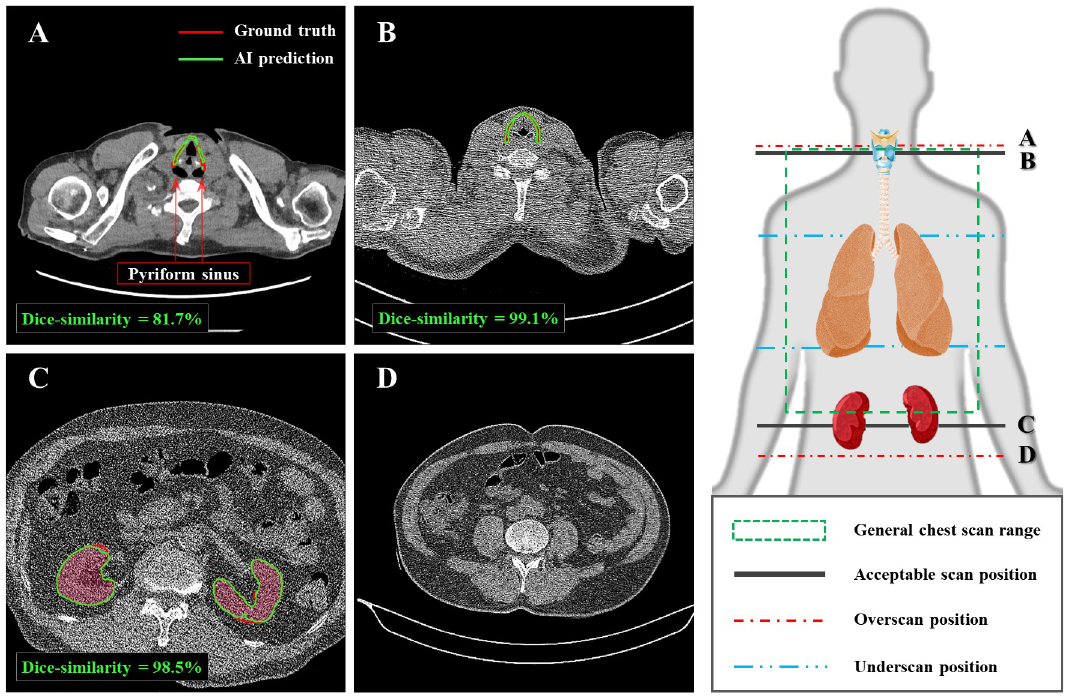
Fig 3. Sample landmark segmentation comparison between AI-assisted model and the experienced radiologist. The results were visualized at different scanning position; (A) segmentation result of superior-side scan at overscan position, (B) that of superior-side scan at acceptable scan position, (C) that of inferior-side scan at acceptable scan position, and (D) inferior-side scanning example at overscan position. Ground truth label and AI-model’s prediction result were displayed with red and green lines, respectively. (W/L: